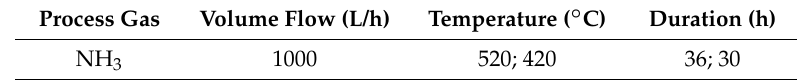
Table 2. Gas-nitriding